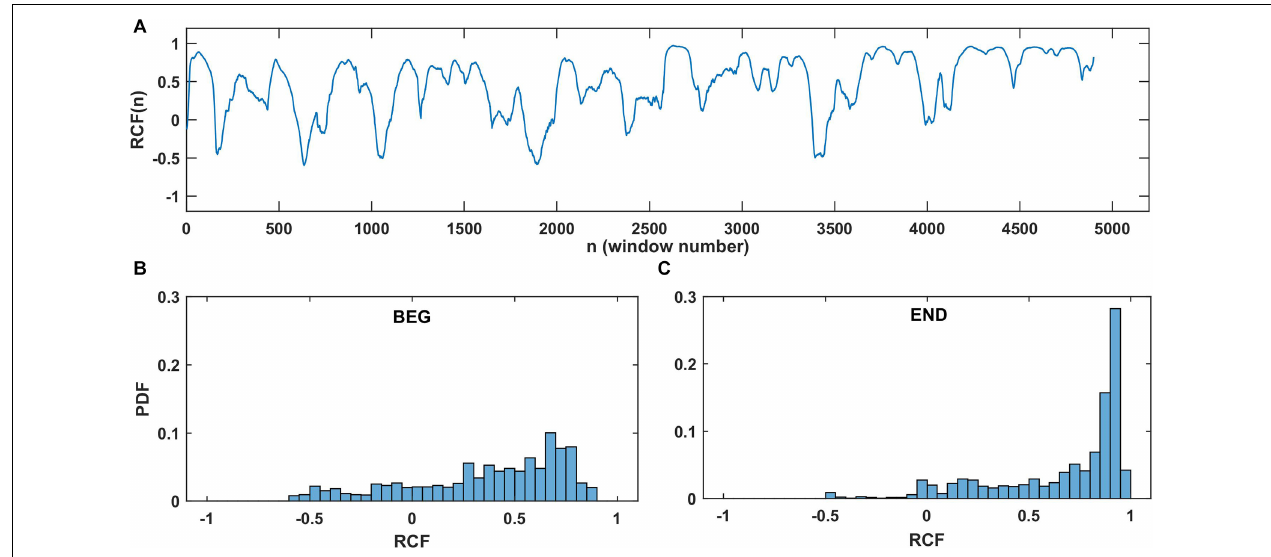
FIGURE 3 | Example of RCF results for the elbow angle series from one participant in one trial. (A) The RCF plot of dataset until fatigue-induced spontaneous task disengagement with no time lag and window W = 150. (B) Probability distributions for RCF in the BEG segment and (C) probability distributions at the END segment. For better visualization, the distributions were constructed with constant number of bins equal to 40 in (B,C) .